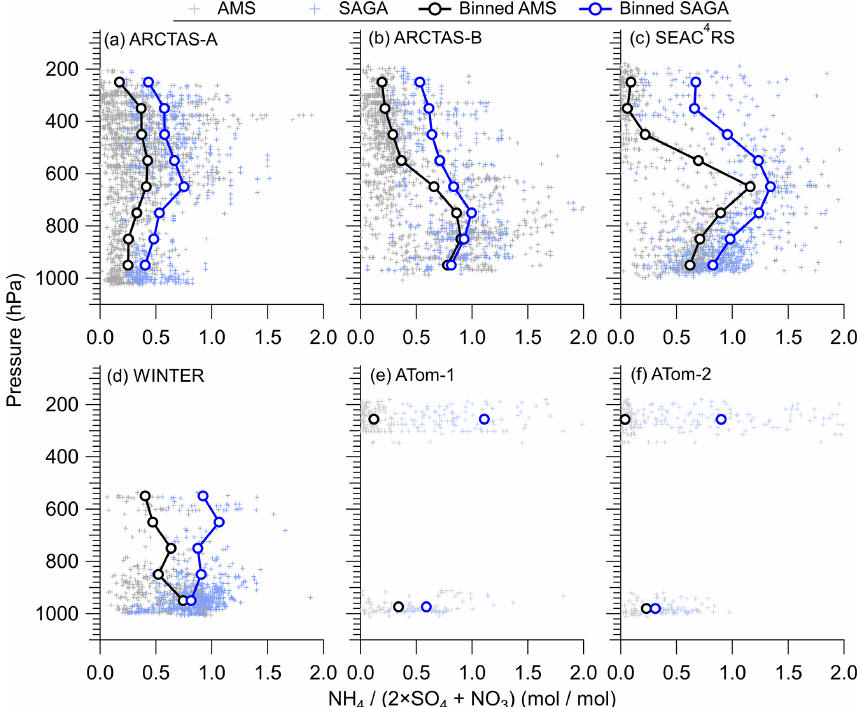
Figure 3. Vertical profiles of ammonium balance ( ( NH 4 / 18 )/( 2 × SO 4 / 96 + NO 3 / 62 ) ) for (a) ARCTAS-A, (b) ARCTAS-B, (c) SEAC 4 RS, (d) WINTER, (e) ATom-1, and (f) ATom-2 for AMS and SAGA. The binned data represent the mean for each 100hPa pressure level. The data have been averaged to the sampling time of SAGA